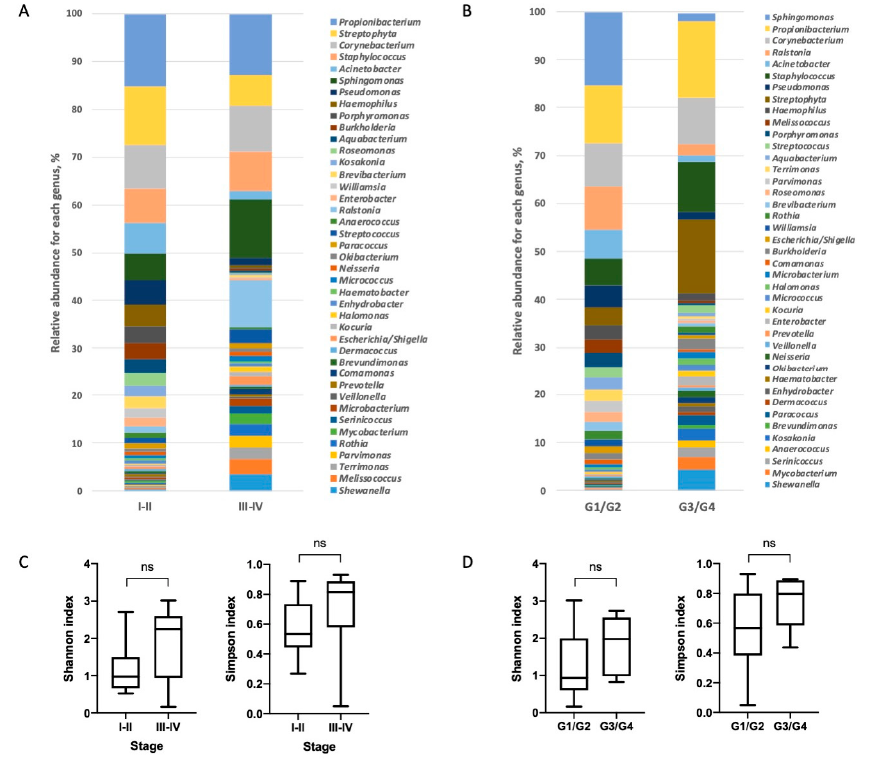
Figure 4. Taxonomic composition of the lung tumor microbiomes at the genus level for tumors at different stages ( A ) and with various differentiations ( B ). Taxonomic alpha-diversity calculated with Shannon and Simpson indices between the early and late stages ( C ) and low and high grades ( D ).